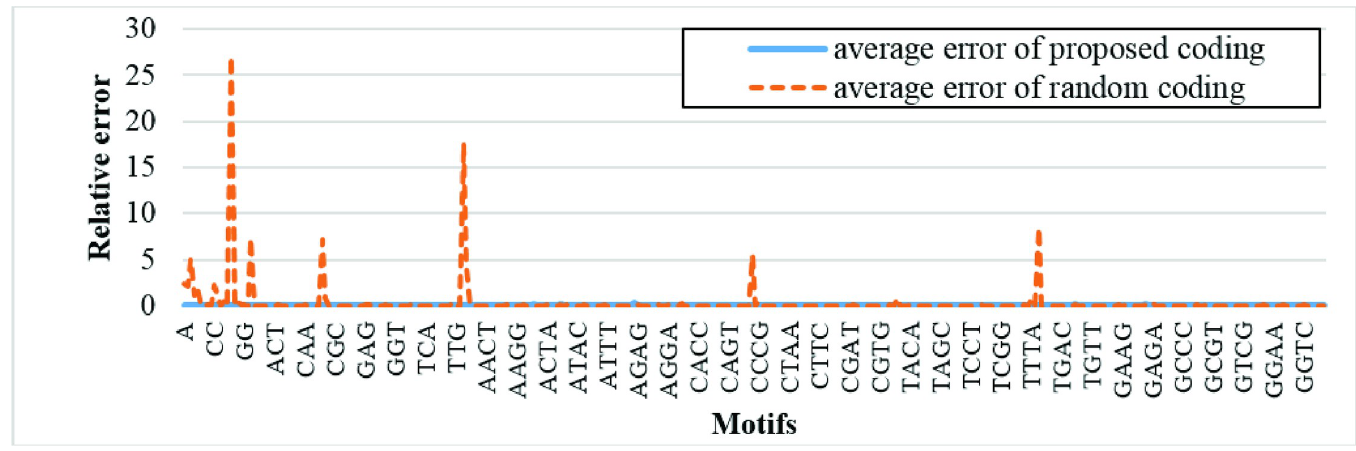
Fig 11. Average relative errors of cross-correlating all encoded sequences with length 1 to 4 with first 1260 bp of first 12 chromosomes of Homo sapiens GRCh38. p12 data.